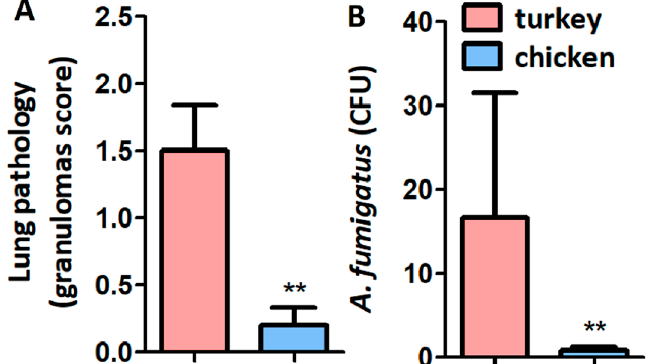
Figure 5. Granuloma score and CFU in turkeys and chickens infected with A. fumigatus . Lung granuloma score ( A ) and CFU counting ( B ) were lower in chicken than in turkeys ( A ). Results shown are means and standard deviation values. Results were compared by Mann-Whitney U test (** p < 0.001; 1 experiment with chickens, n = 5 and 2 experiments with turkeys, n = 10).